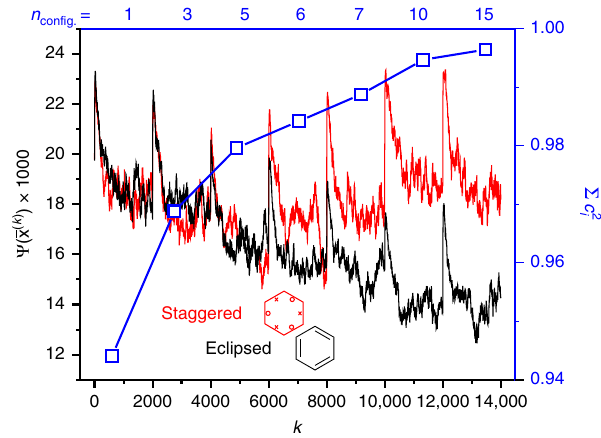
Fig. 2 Analysis of the (30,18) CAS-CI wavefunction by DVMS. In red and black, the wavefunction value at the Voronoi site for staggered and eclipsed Kekulé structures, as a function of k , the number of DVMS cycles. In blue, the cumulative completeness of the (30,18)